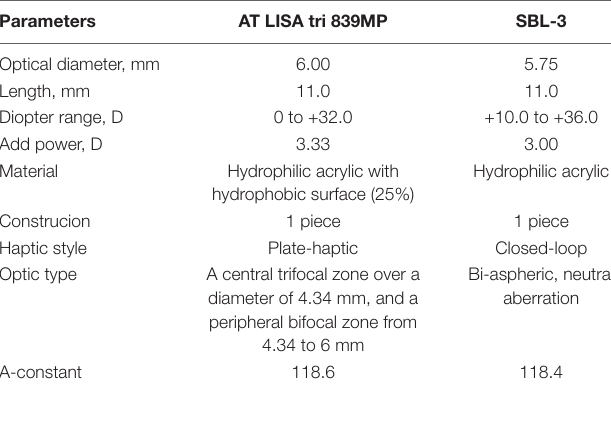
TABLE 1 | Characteristics of the two multifocal intraocular